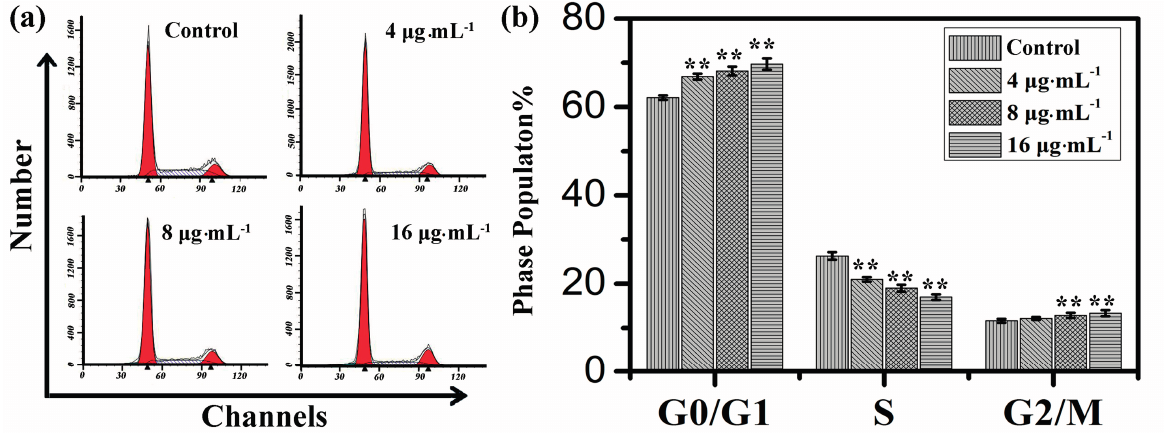
Figure 3. ( a ) Flow cytometry analysis on cell cycle of IEC-6 treated with kansenone of different concentration for 48 h; ( b ) Cell cycle distribution of IEC-6 cells. Compared with corresponding control group, ** p <